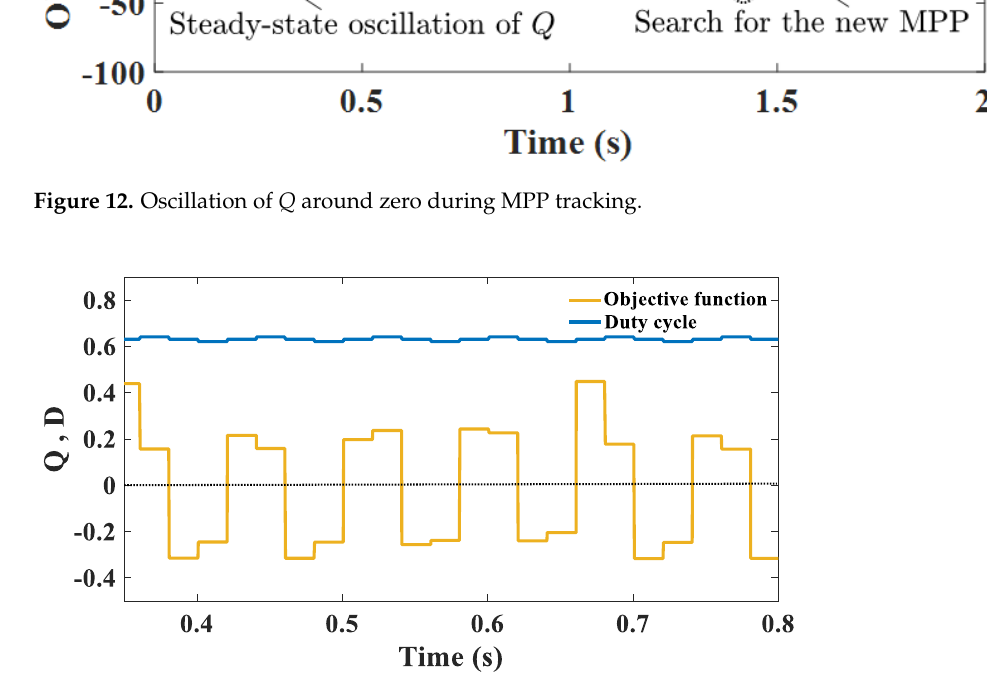
Figure 13. Zoomed portion of Q oscillation considering the dynamics of the system.